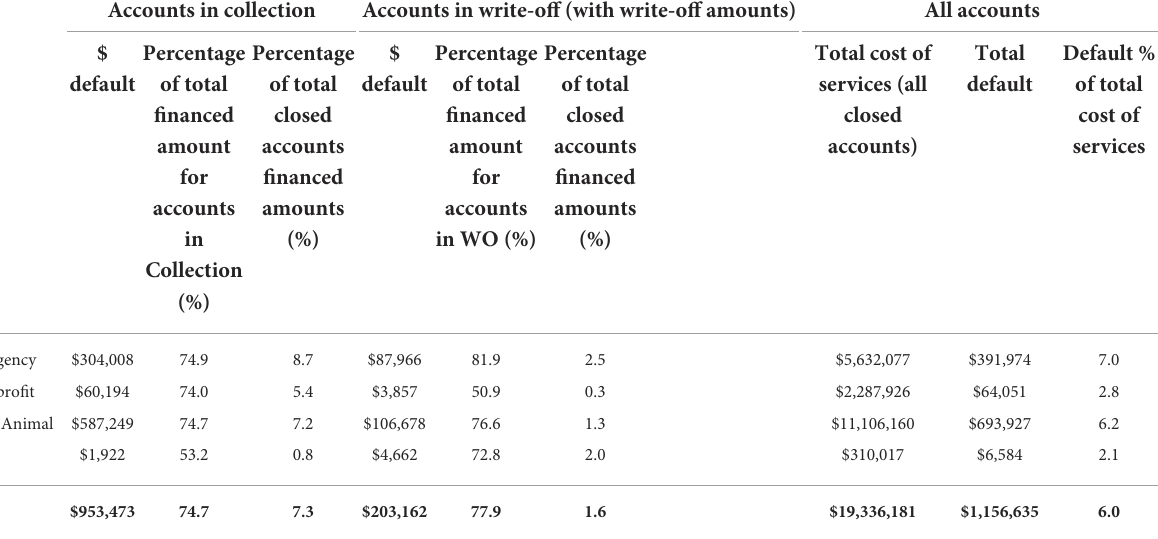
TABLE 3 Default by organization